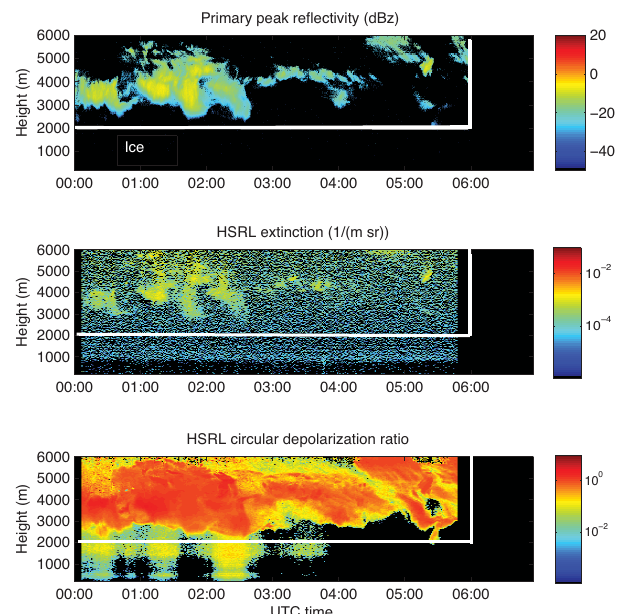
Figure 7. As in Fig. 5, but for 22 October 2004. White outlined area shows ice cloud.